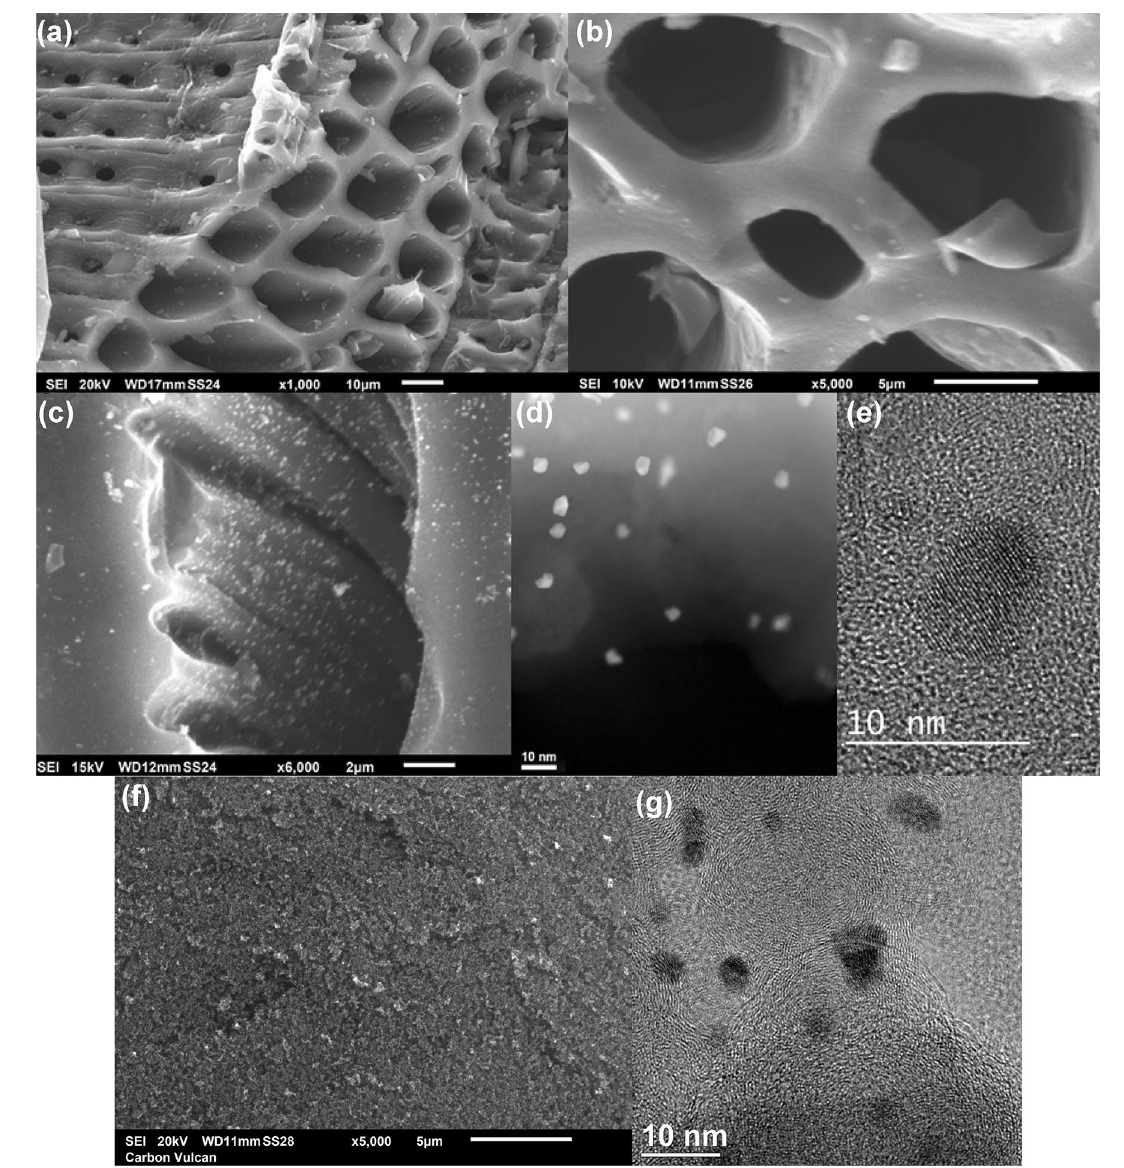
Fig. 4 SEM micrographs of biocarbon ( a ) and ( b ), Pd/BC ( c ), STEM micrograph of Pd/BC ( d ), TEM micrograph of Pd/BC ( e ), SEM micro- graphs of carbon Vulcan XC 72 ( f ) and TEM micrograph of Pd/C ( g